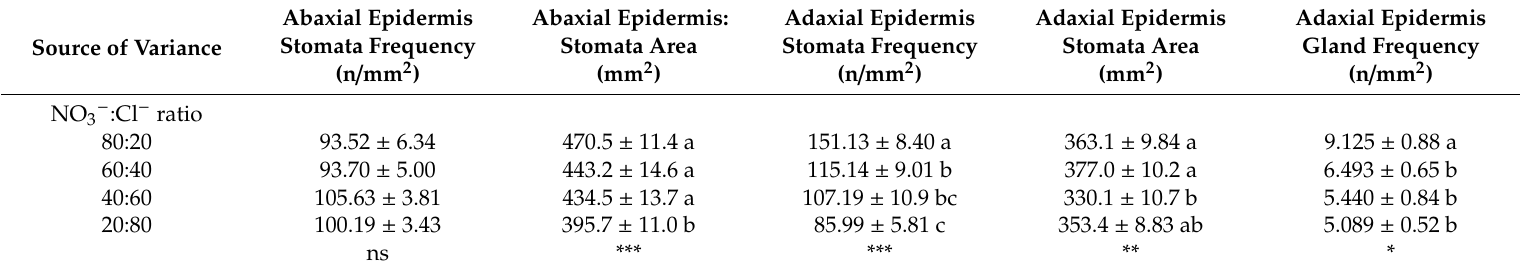
Asterisks indicate a statistically significant di ff erence (***: p < 0.001; **: p < 0.01; *: p < 0.05; ns: non-significant, p ≥ 0.05). For each source of variance, di ff erent letters within each column indicate statistically di ff erent groups according to the Duncan’s post-hoc test ( p = 0.05). The factor “Cut” was analyzed using an independent Student’s t-test. Data are mean values ± standard error, n = 3. Table 7. Analysis of variance and mean comparisons for the mesophyll traits in leaves of basil cultivated under di ff erent NO 3 − :Cl − ratios in the nutrient solution. Source of Variance